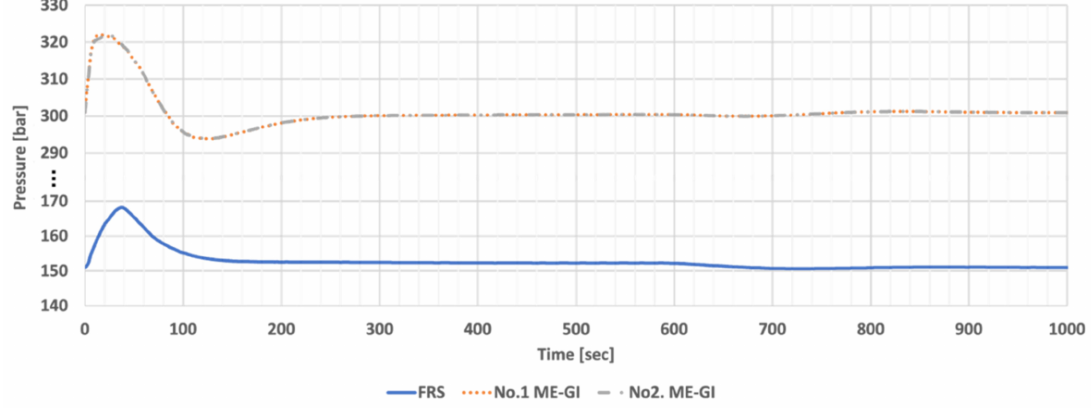
Figure 19. Pressure of each line when two engines are tripped.